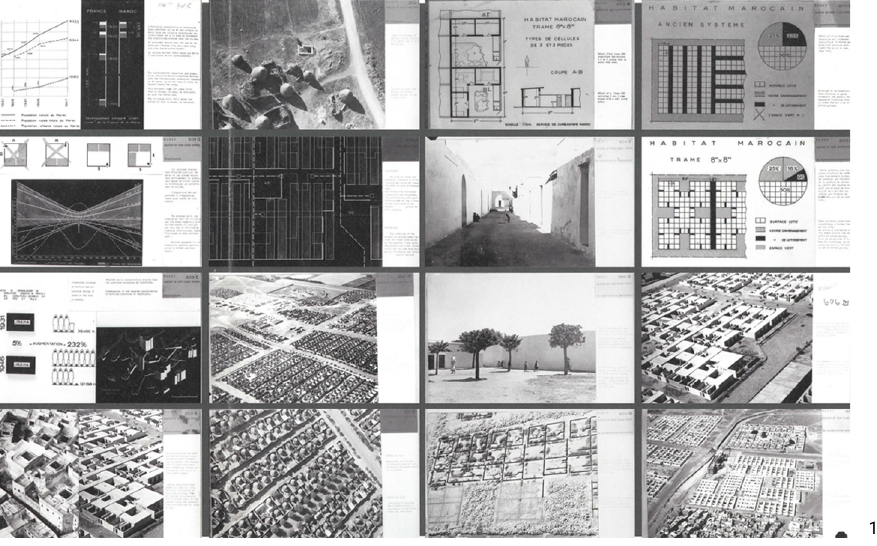
Fragments of the ‘GAMMA grid’. From: Francis Strauvan. Aldo van Eyck. The Shape of Relativity. Amsterdam: Archi- tectura & Natura,